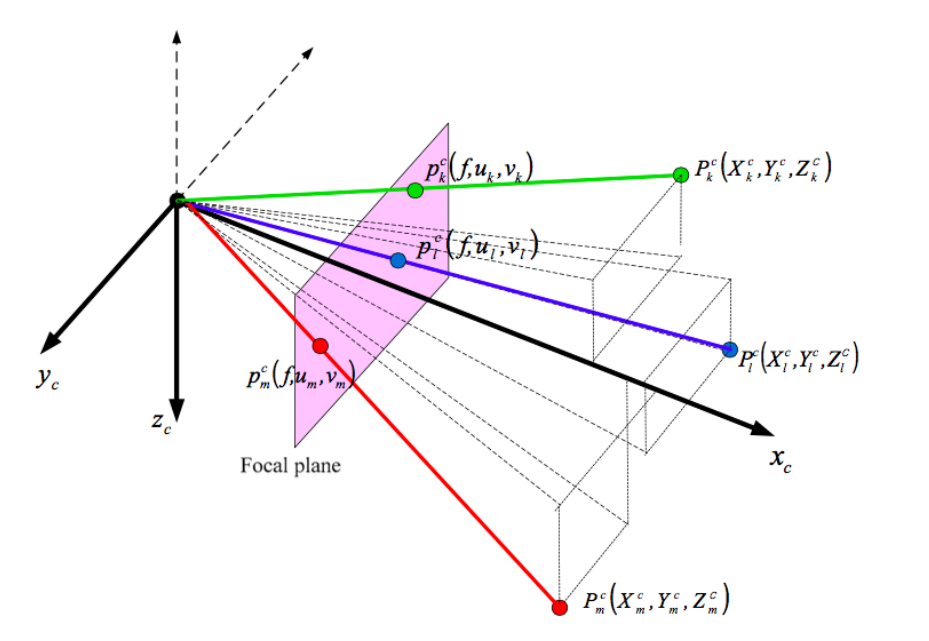
Figure 2. Landmark measurements in the vision navigation